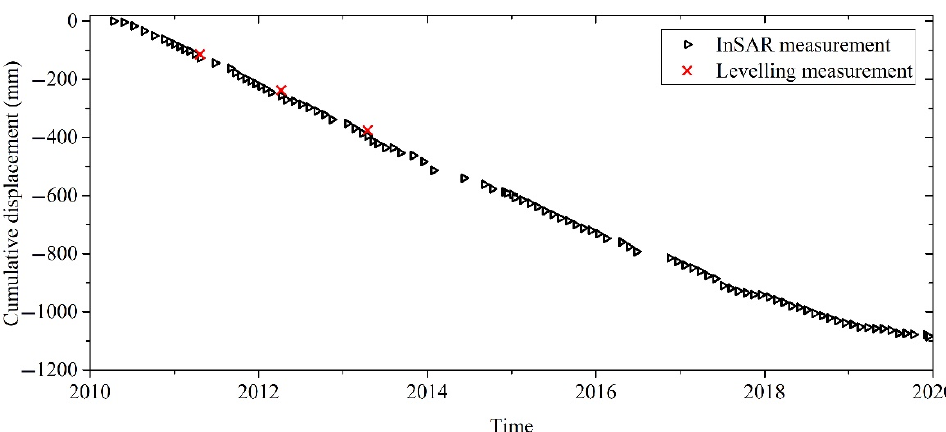
Figure 5. Time series displacement from the PS-InSAR measurement and levelling measurement.